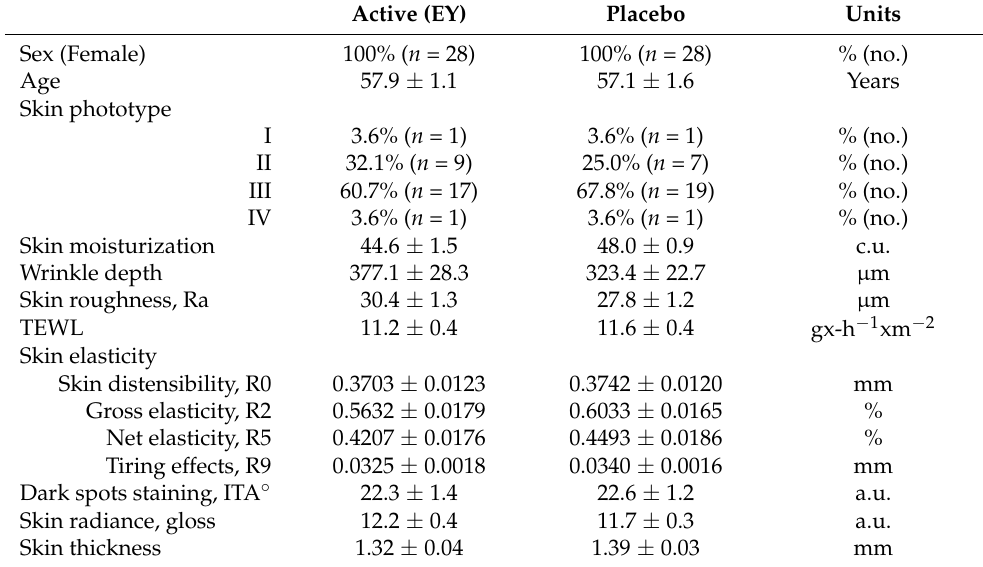
Table 1. Baseline and demographic